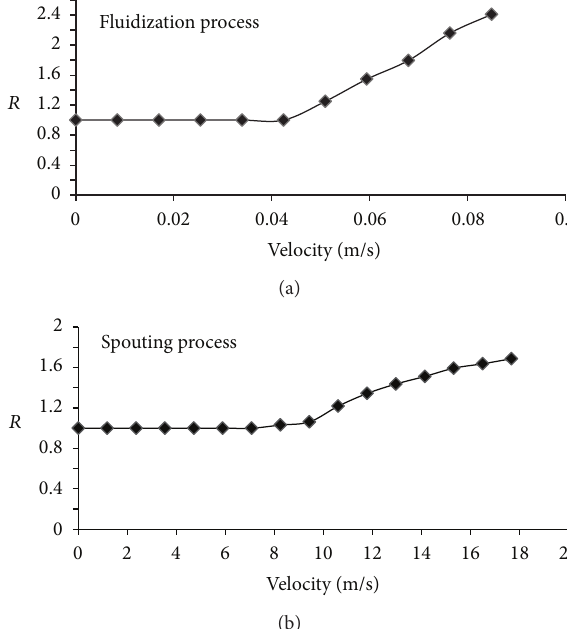
Figure 4: Comparison of bed expansion ratio for fine particles.